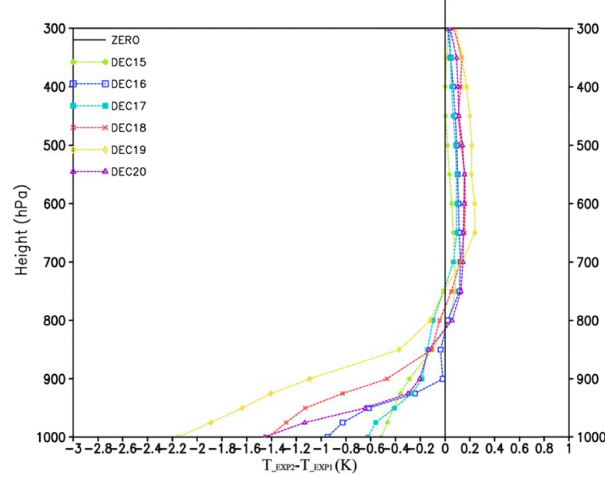
Figure 6. Profiles of average temperature change in Jing–Jin–Ji ow- ing to the AF (K) during the 15–20 December 2016